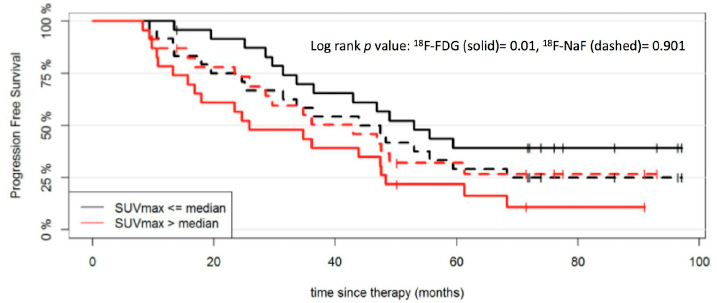
Figure 3. PFS outcome after start of therapy according to SUV max derived from reference tissue for 18 F ‐ NaF and 18 F ‐ FDG PET/CT. The patient cohort is dichotomized at the median SUV max values for 18 F-NaF (12.9) and 18 F-FDG